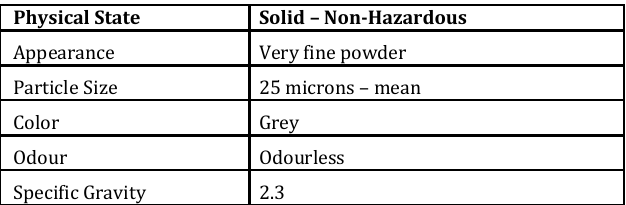
Table 2: Physical properties of procured Rice Husk